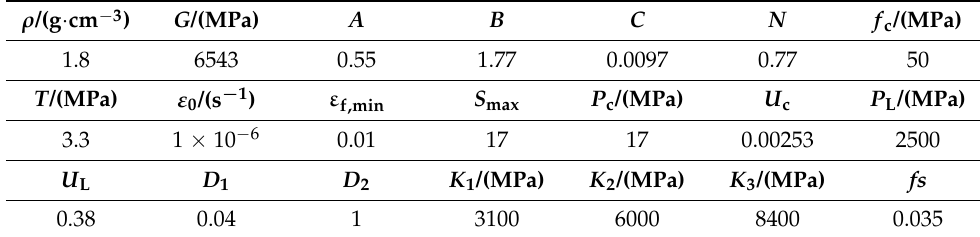
Table 2. HJC model parameters of the tuff